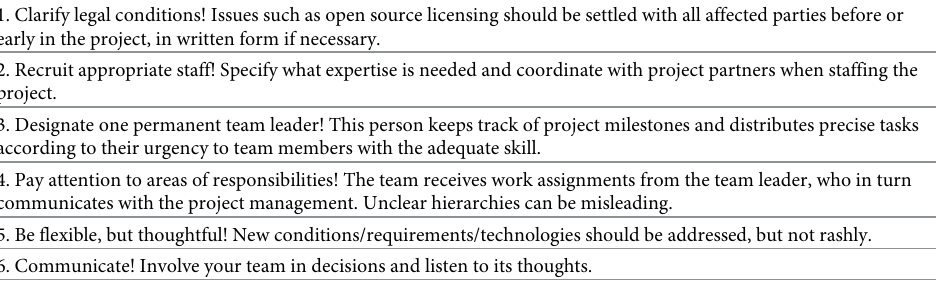
Table 2. Six key recommendations for similar